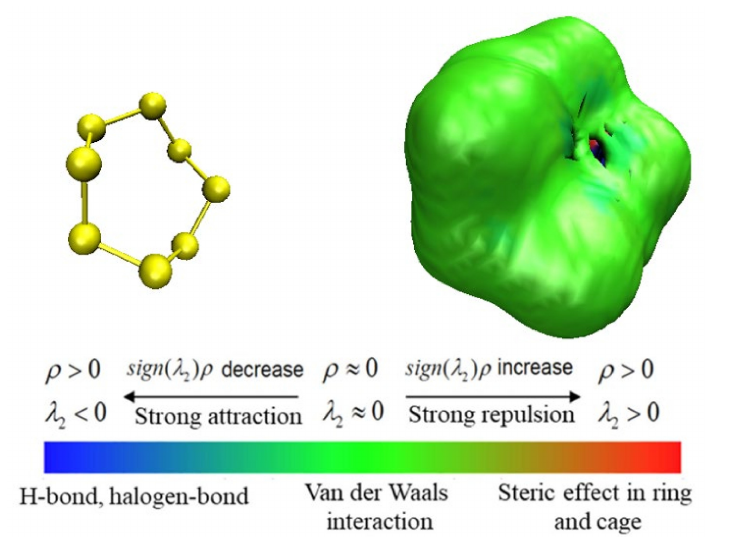
Figure 6. Schematic diagram of average reduced density gradient (aRDG) of single S 8 molecule in CS 2